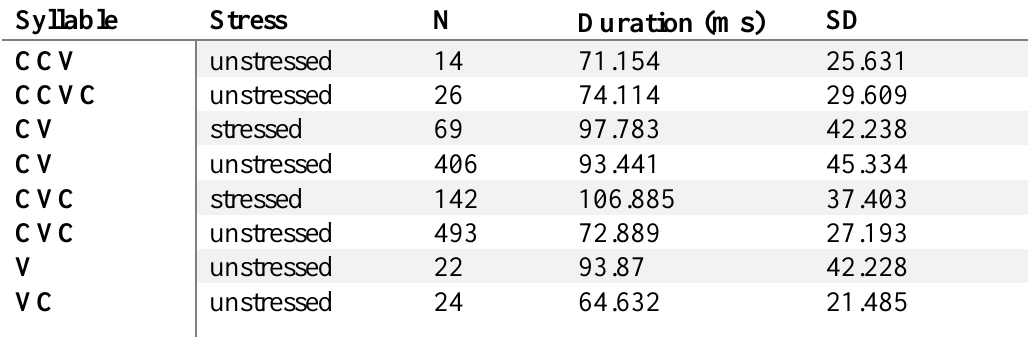
Table 2. Mean duration data (milliseconds) for stressed and unstressed subset for syllable type